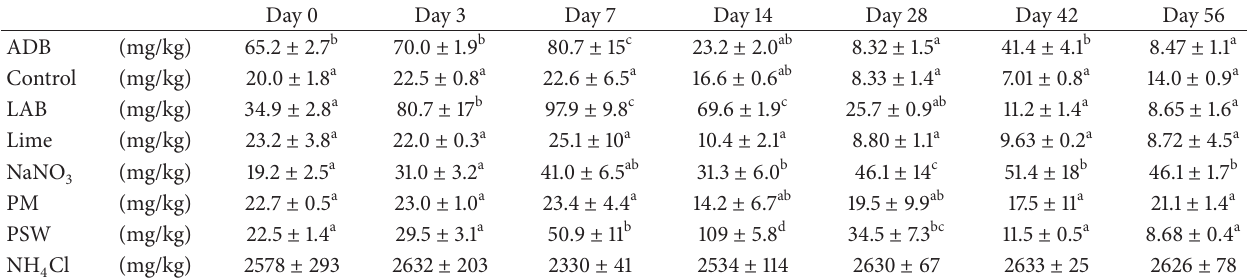
+ concentration of treated soils (dry weight) after incubation at 12.5 ∘ C for 56 Table 3: NH 4